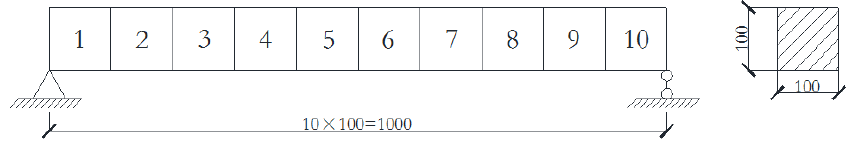
Figure 3. A 10 m-span beam structure (unit: cm).